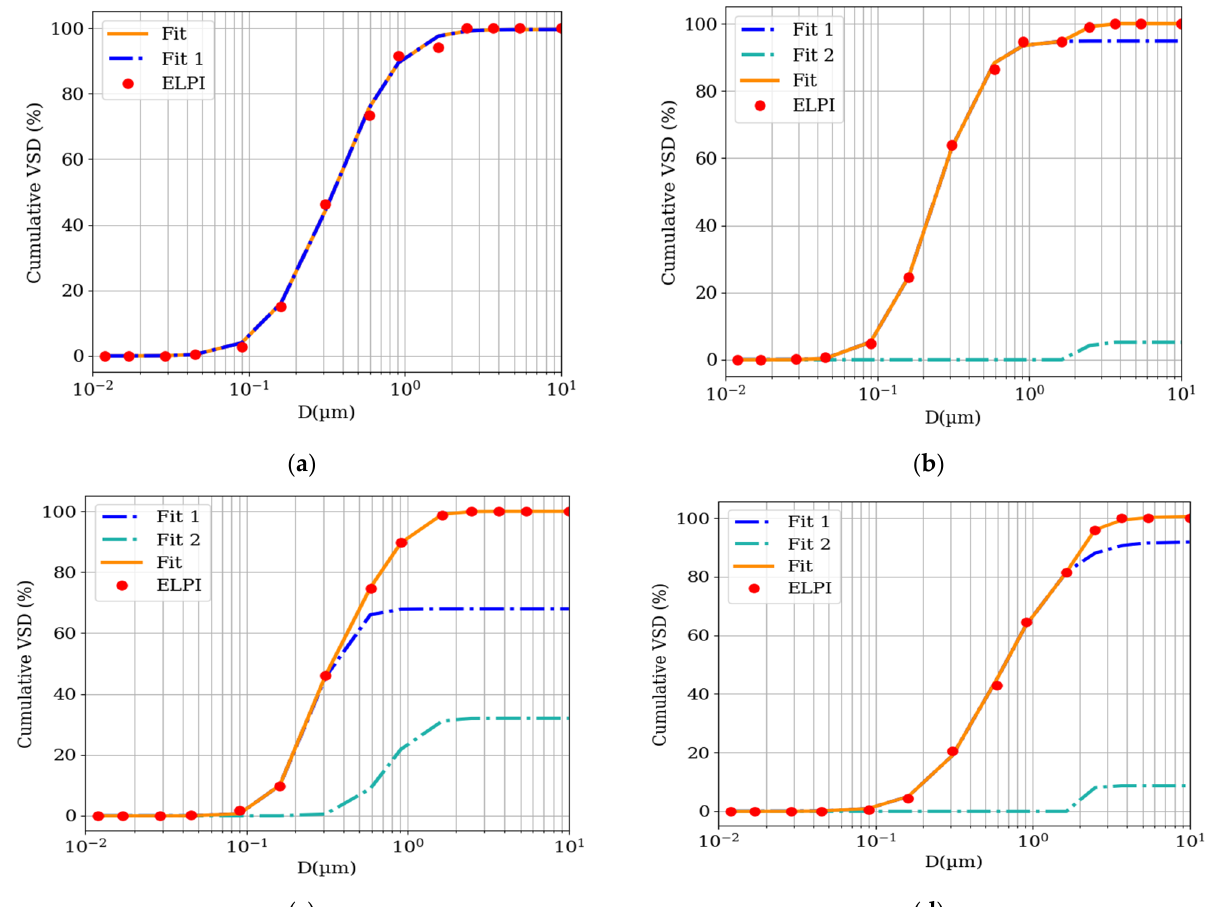
Figure 2. Cumulative volume size distributions of particles emitted during ( a ) pinewood (PINE), ( b ) laminated particle board (LPB), ( c ) PUR foam, and ( d ) PMMA fires. The red dots represent the results obtained with ELPI. The orange line is the best-fit line parametrization of the distribution based on two summands (blue: Fit 1, sea green: Fit 2). In the case of pinewood, it was impossible to fit the sum of two distributions; therefore, the orange line overlaps the blue one. Table 2. Fitted volume abundance (cid:1853) , mean diameter (cid:1830) (cid:3040) , geometric standard deviation (cid:1833)(cid:1845)(cid:1830) , and mass abundance (cid:1854) of the particles emitted during pinewood (PINE), laminated particle board (LPB), polyurethane (PUR), and poly(methyl methacrylate) (PMMA) fires.